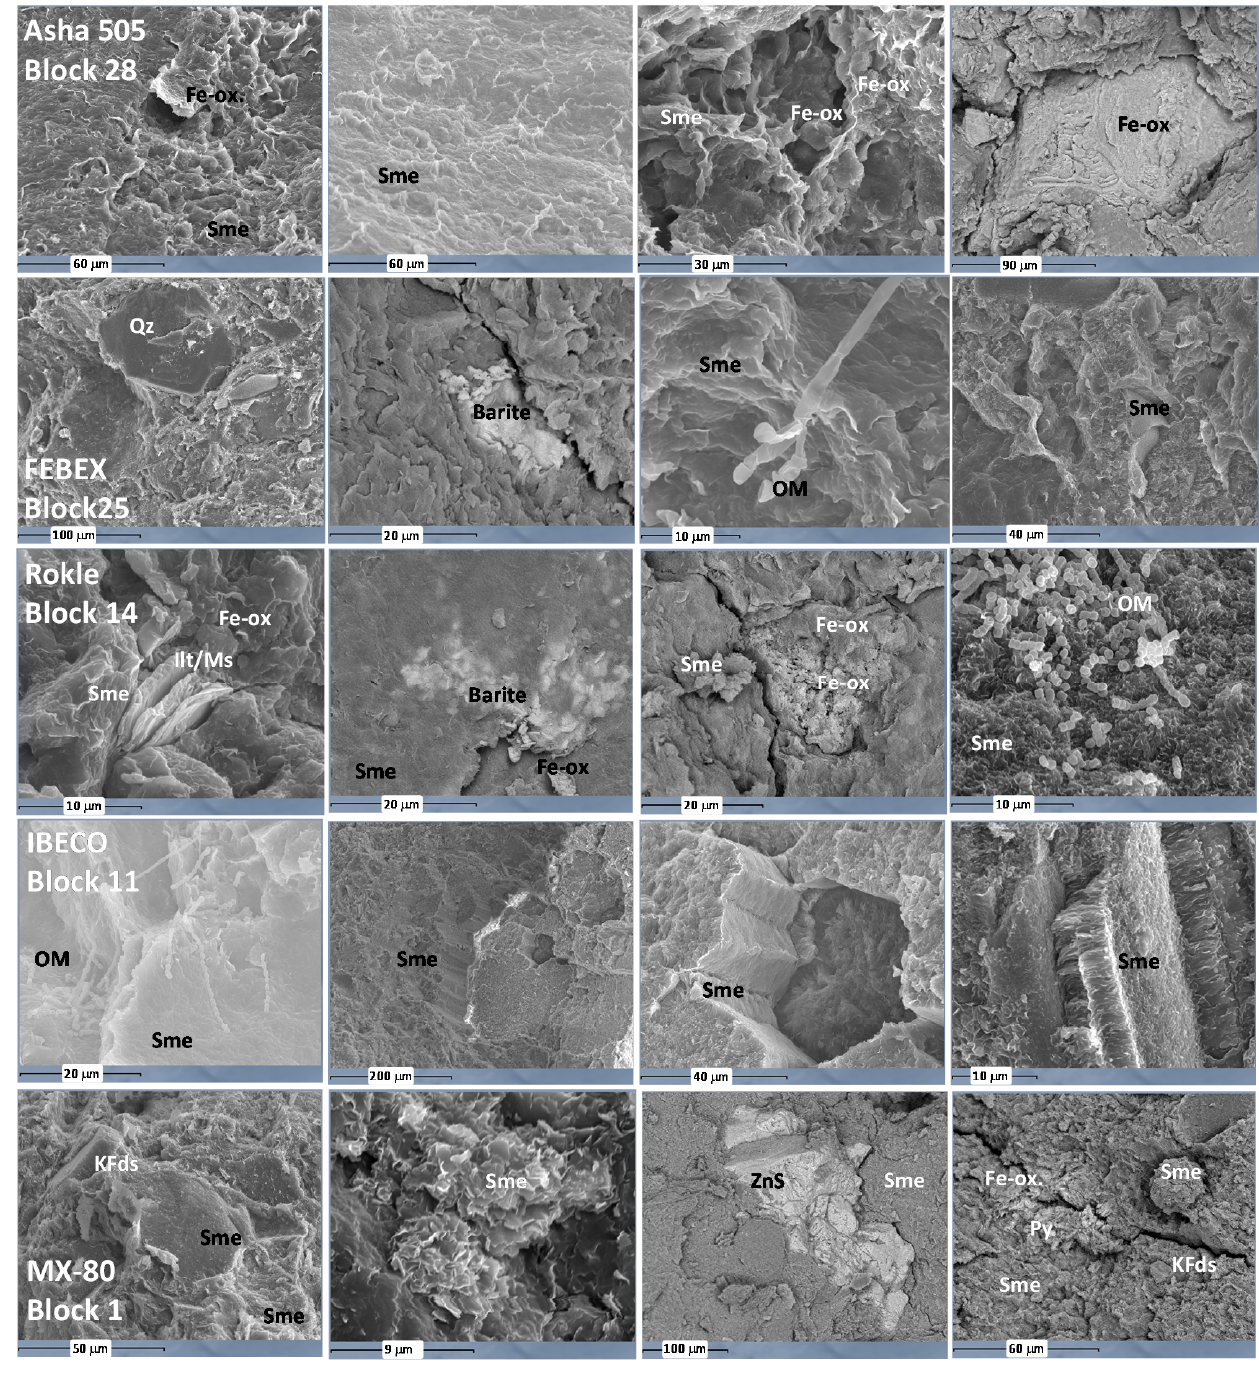
Figure 9. SEM photomicrographs from different bentonites in direct contact with the heater (Sme: esmectite, Ilt/Ms: illite/muscovite, Qz: quartz, ZnS: sphalerite, Fe-ox: Fe-oxyhydroxides, OM: organic matter (hyphae), Py: pyrite, KFds: potassium feldspars).